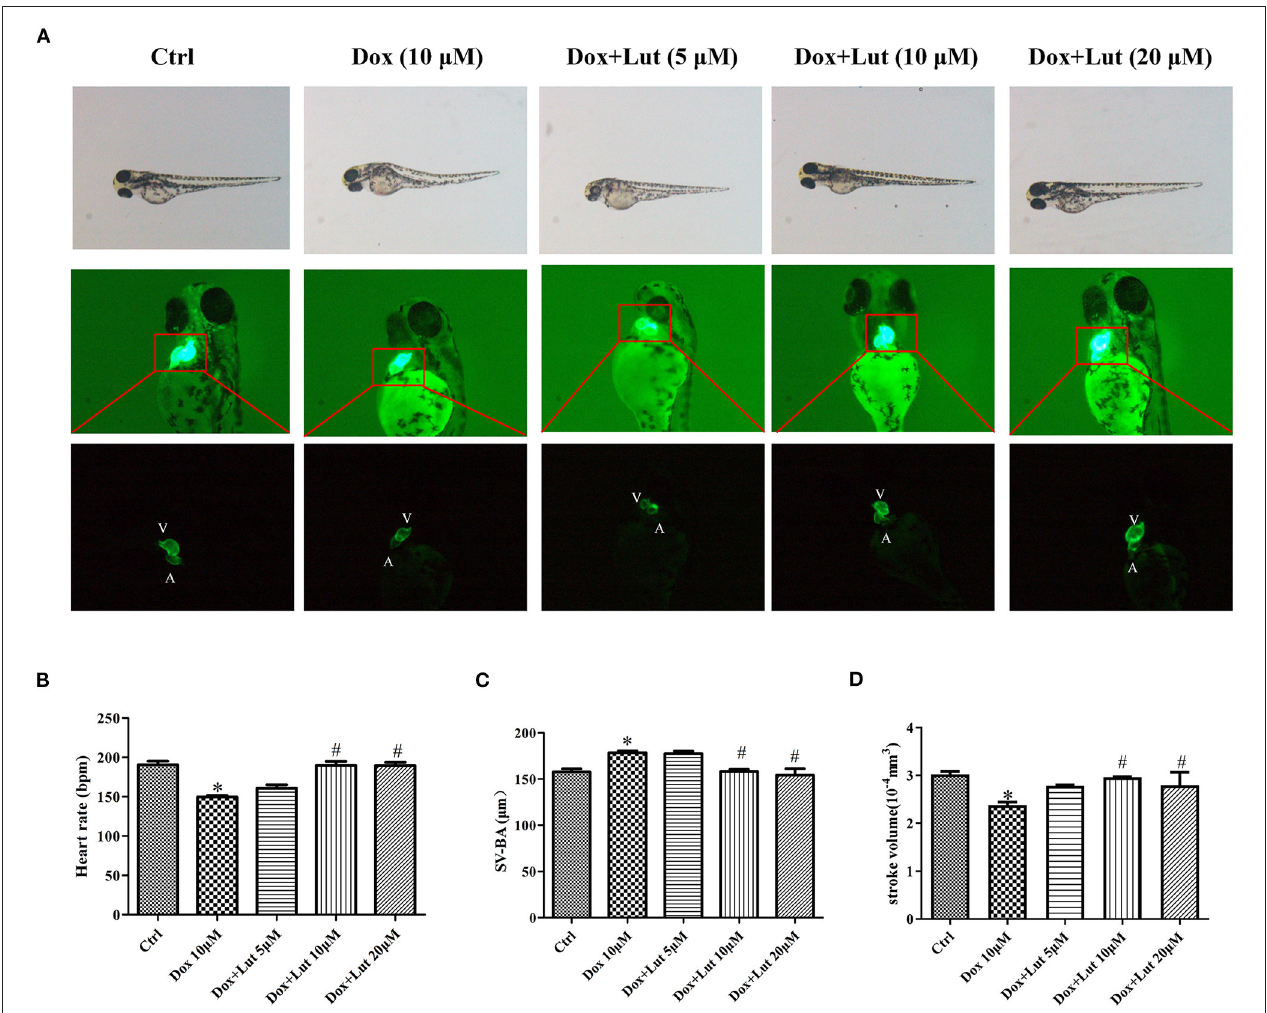
FIGURE 6 | Lut protected the loss of ventricular function in zebrafish. (A) Representative images of zebrafish heart after treatment with Dox in the presence or absence of Lut. A: atrium, V: ventricle. Zebrafish were co-treated with Dox and Lut. The changes in (B) heart rate and (C) SA–BA (D) stroke volume were measured. Mean ± SD, n = 3 independent experiment. * P < 0.05 compared with control group. # P < 0.05 compared with Dox